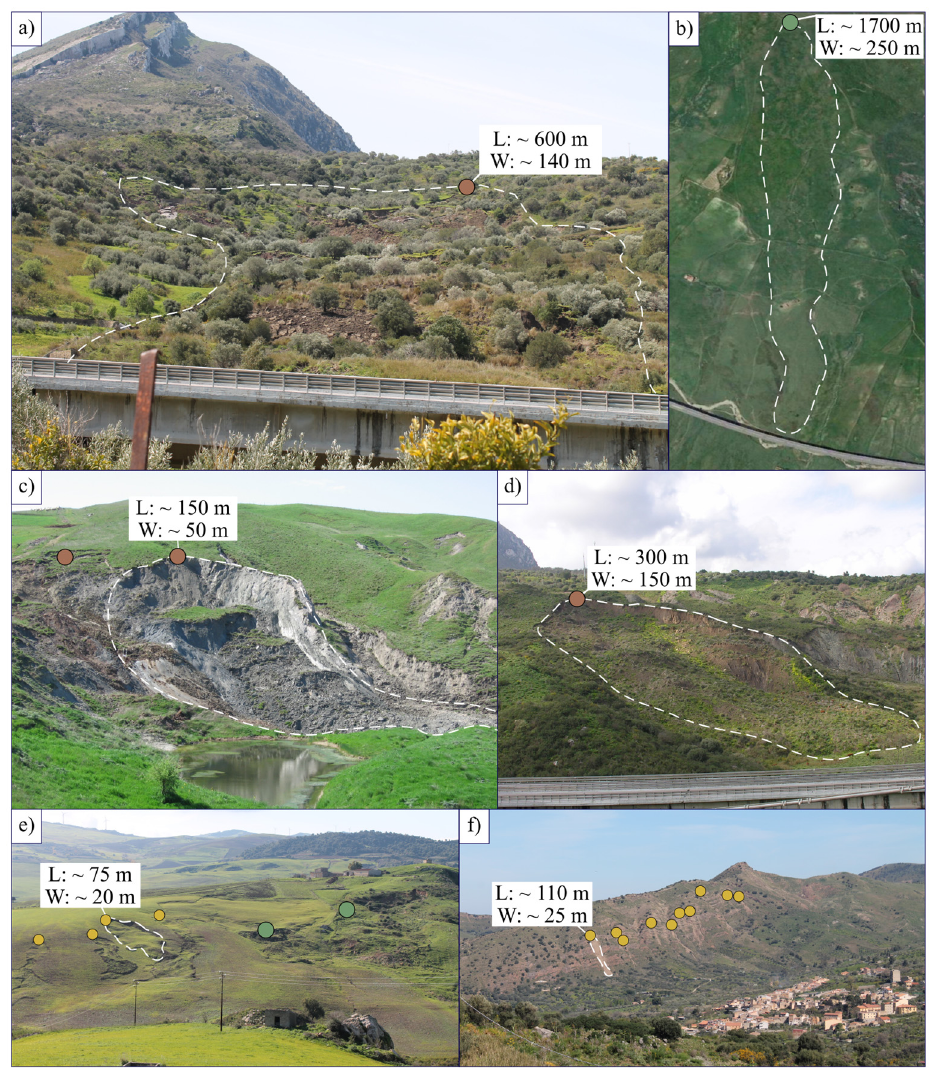
Figure 2. Some examples of the three types of landslides analysed located in the study area: slides ( a , c ,), slope flows ( b , d ) and local flows ( e , f ). LIPs are reported according to the legend of Figure 1 (brown for slide, green for slope flow and light orange for local flow). Morphometric scale references (L = length; W = width) are given for selected